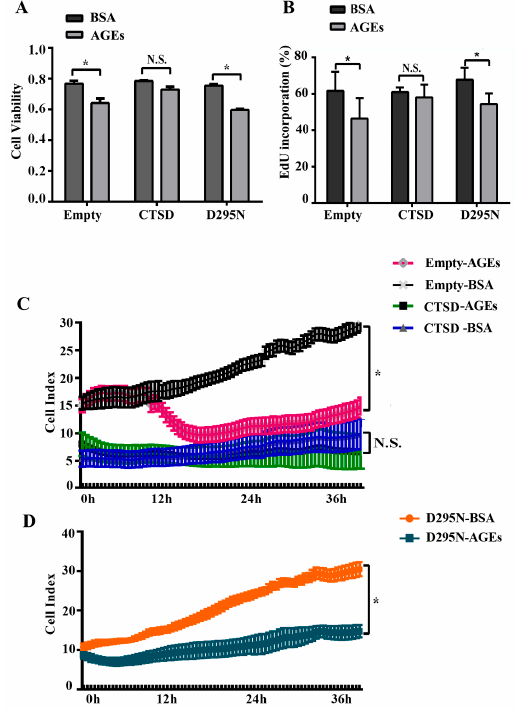
Figure 5. The effects of CTSD on the proliferation of HUVECs. Lentiviral plasmids containing wild-type CTSD or D295N CTSD complementary deoxyribonucleic acid (cDNA) were transduced into cells,